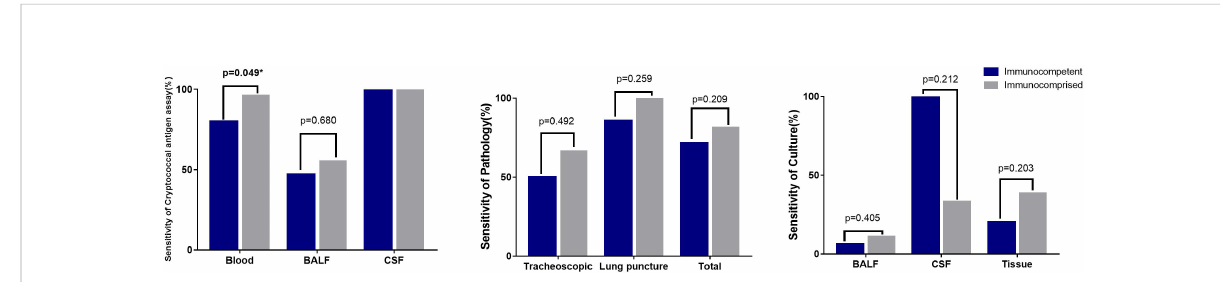
FIGURE 4 Sensitivity of different detection methods in different samples Sensitivity of 2 skin pathology from immunocomprised patients was 100%. The CSF culture in one immunocomptent patients of CNS cryptococcus infection was positive (100%), and 2 samples of CSF culture were positive from 6 samples of immunocomprised patients